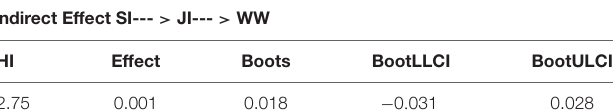
TABLE 7 | Indirect effect.